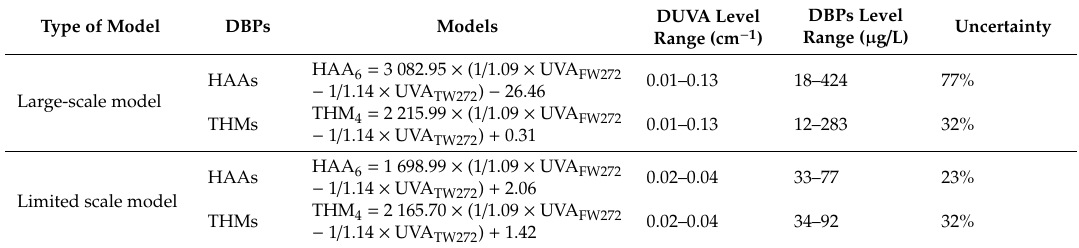
Table 5. Models for DBP levels estimation from DUVA measurement with FW and TW probes (n =